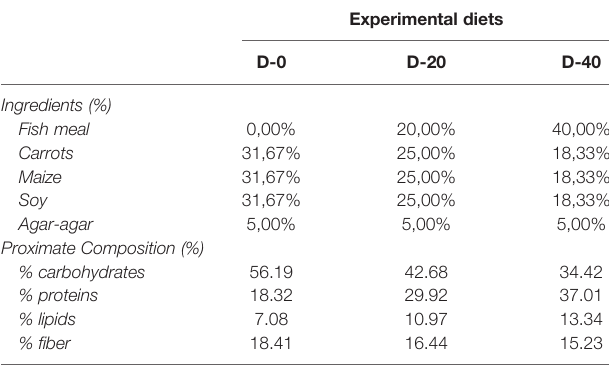
TABLE 2 | Formulation and proximate composition of the three experimental